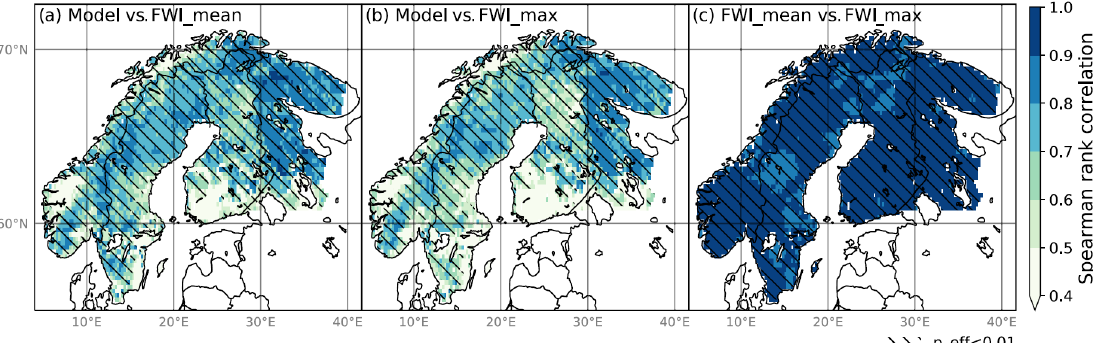
Figure 9. Spearman rank correlation of (a) the data-driven model and FWI_mean, (b) the data-driven model and FWI_max, and (c) FWI_mean and FWI_max. The correlations are calculated using the test set. Hatches indicate regions of an effective p value (i.e. p value accounting for autocorrelation) smaller than